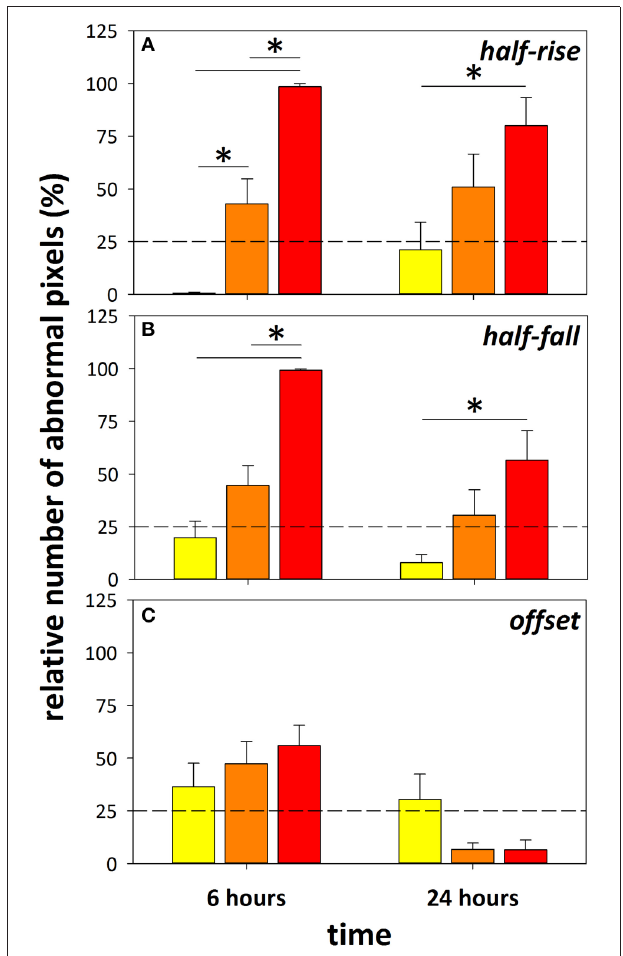
FIGURE 3 | Using the retina as a platform to determine optimal concentration of DOC. Index of injury showing the proportion of pixels (%) that fell beyond a 75% criterion cut-off developed from the control group. Data from eyes treated with 0.02M (yellow), 0.06M (orange), and 0.2M (red) DOC at 6 and 24h in the half-rise (A) , half-fall (B) , and offset (C) are shown. *Denotes significance between groups with two-way ANOVA and Tukey’s multiple comparisons test. Data falling beyond the dashed line marking 25% indicates significant change from control group, mean ± SEM, n = 10 eyes/group.